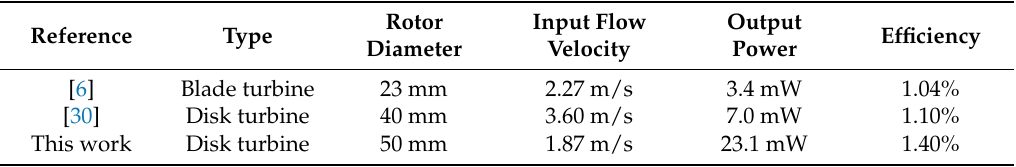
Table 2. Comparison with other electromagnetic energy harvesters from fluid